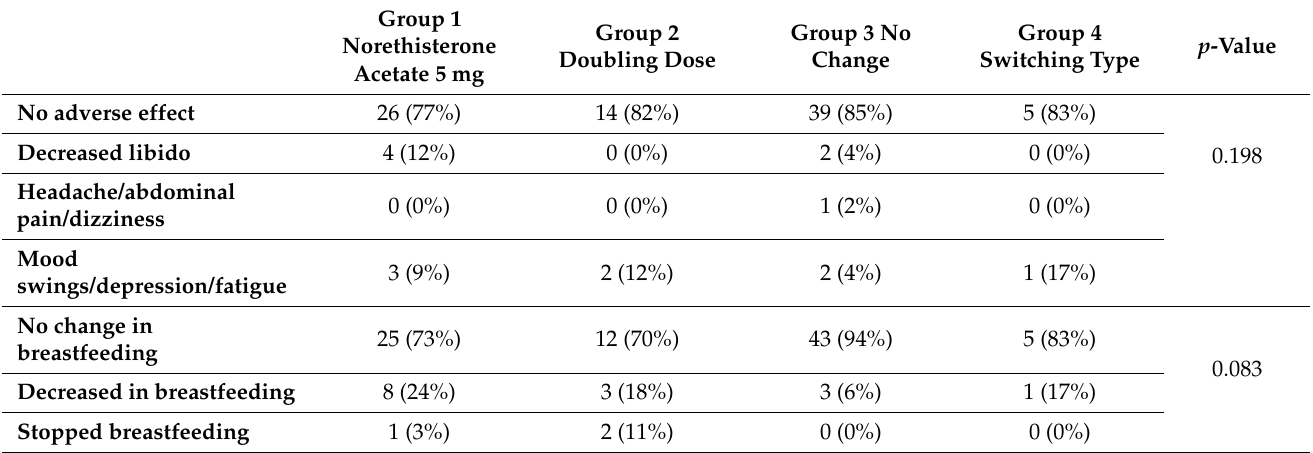
Table 5. Side effects at six